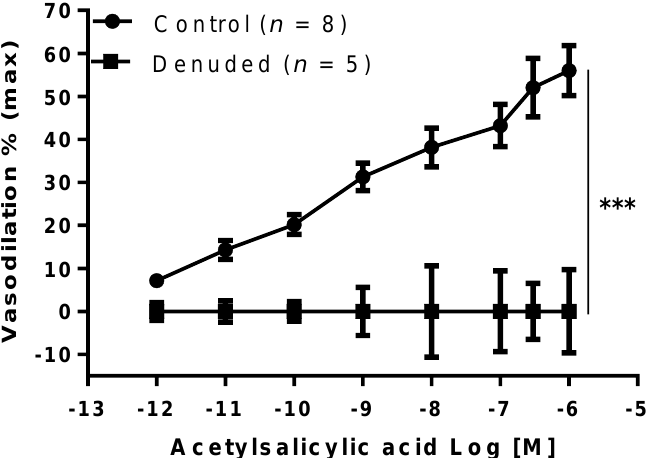
Figure 2 . Acetylsalicylic acid effect on entire and denuded mesenteric arteries. Acetylsalicylic acid was tested on phenylephrine preconstricted mesenteric arteries entire (Control) and without endothelium (Denuded) isolated from gravid rats. Data are reported as mean ± SEM, n = number of experiments. *** p < 0.001 (two-way ANOVA).